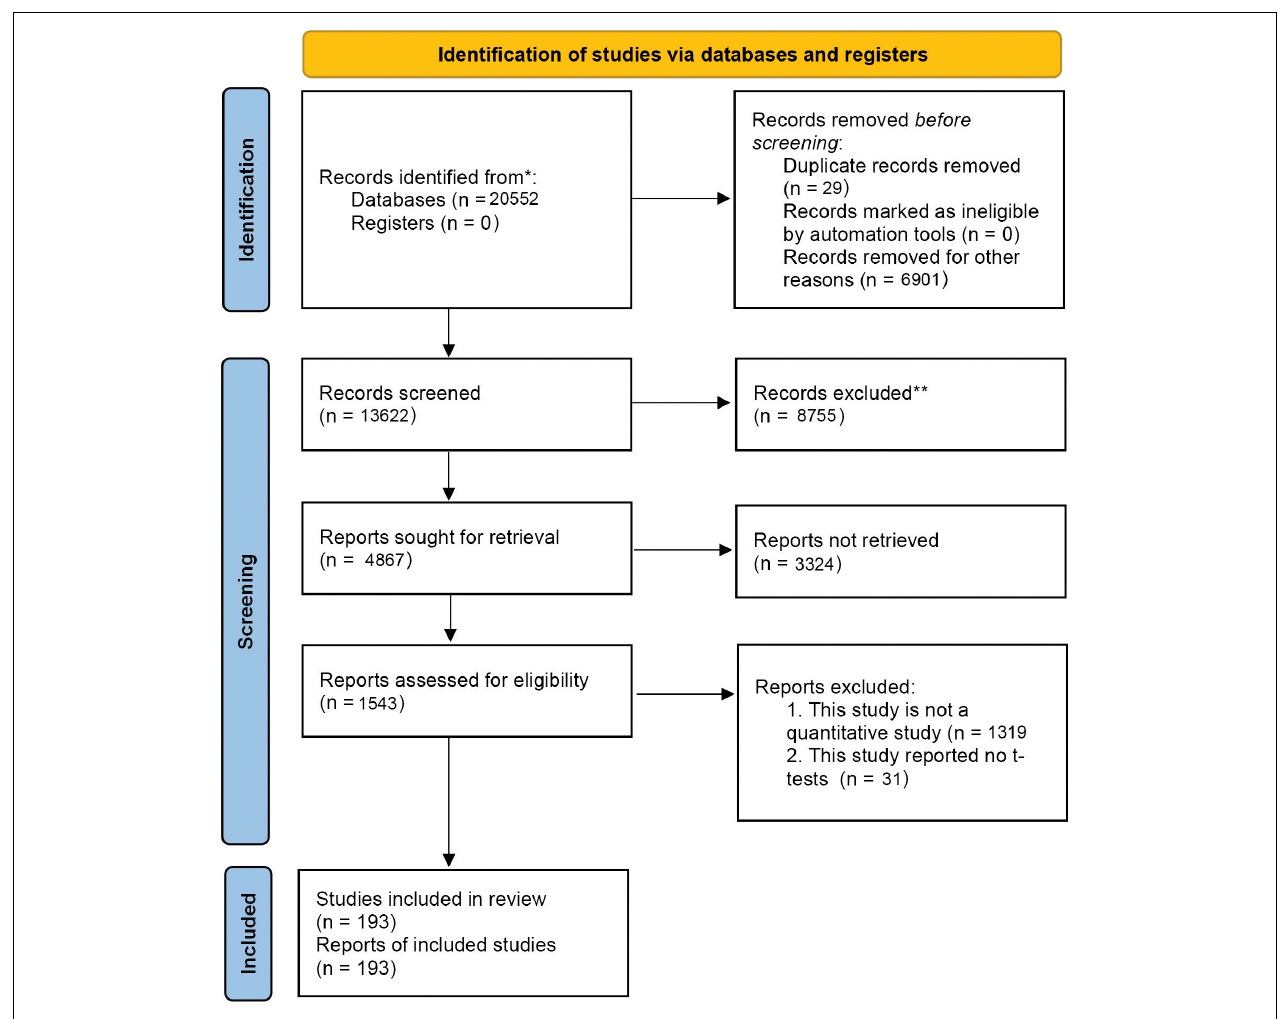
FIGURE 1 | PRISMA 2020 flow diagram for the current